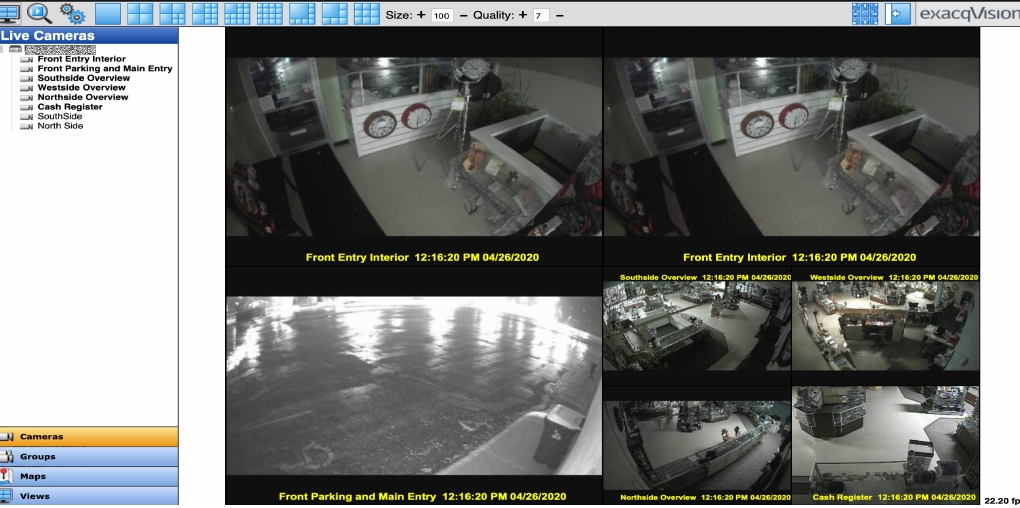
Figure A2. Example of another weakly protected Exacqvision video-surveillance